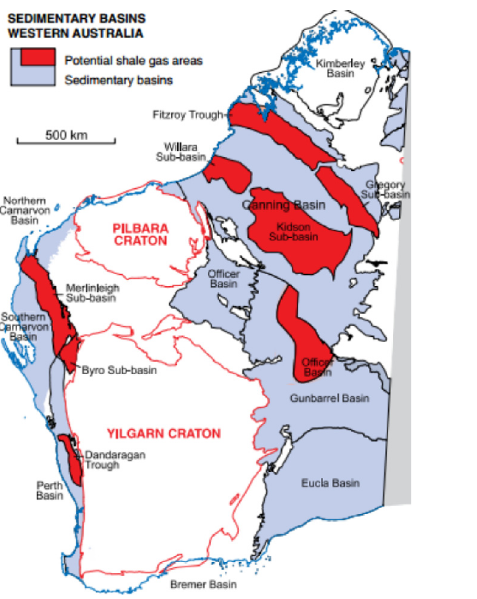
Fig. 1. Map showing WA onshore gas